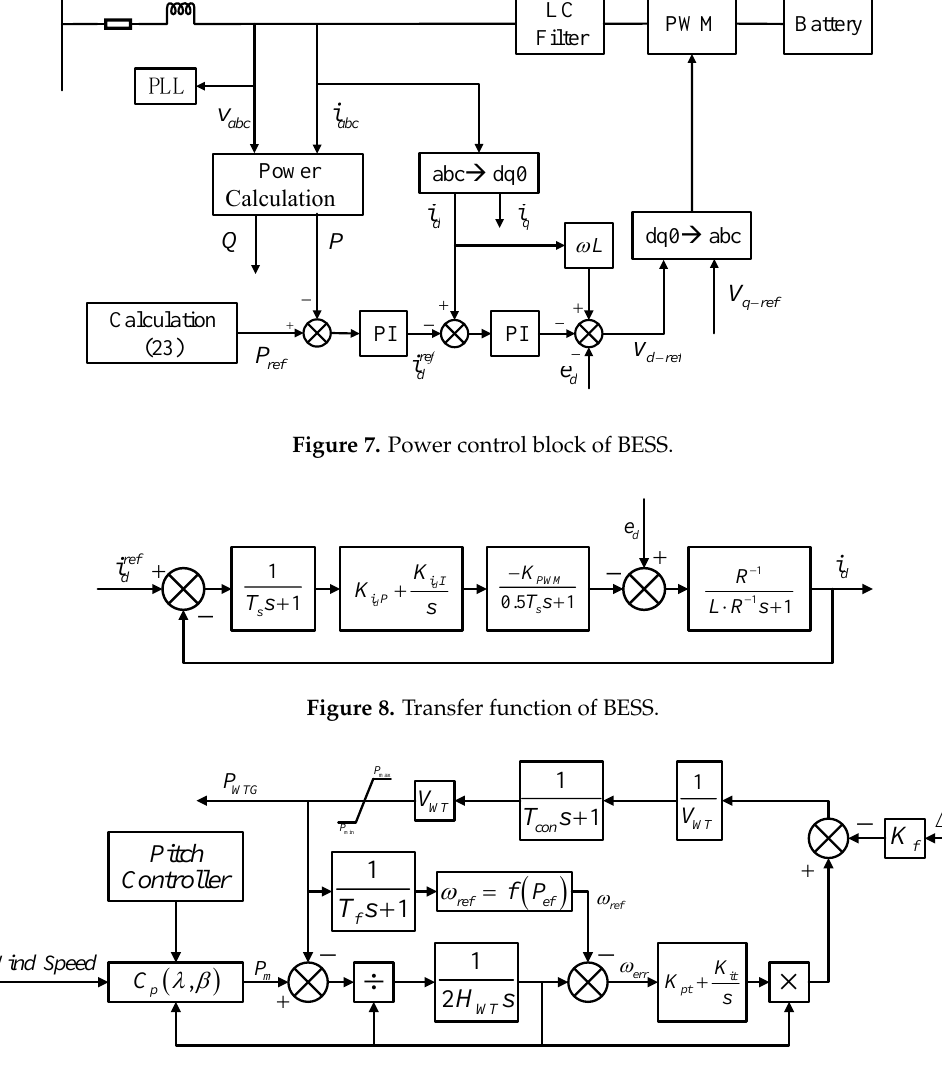
Figure 9. Simulation model of wind turbine